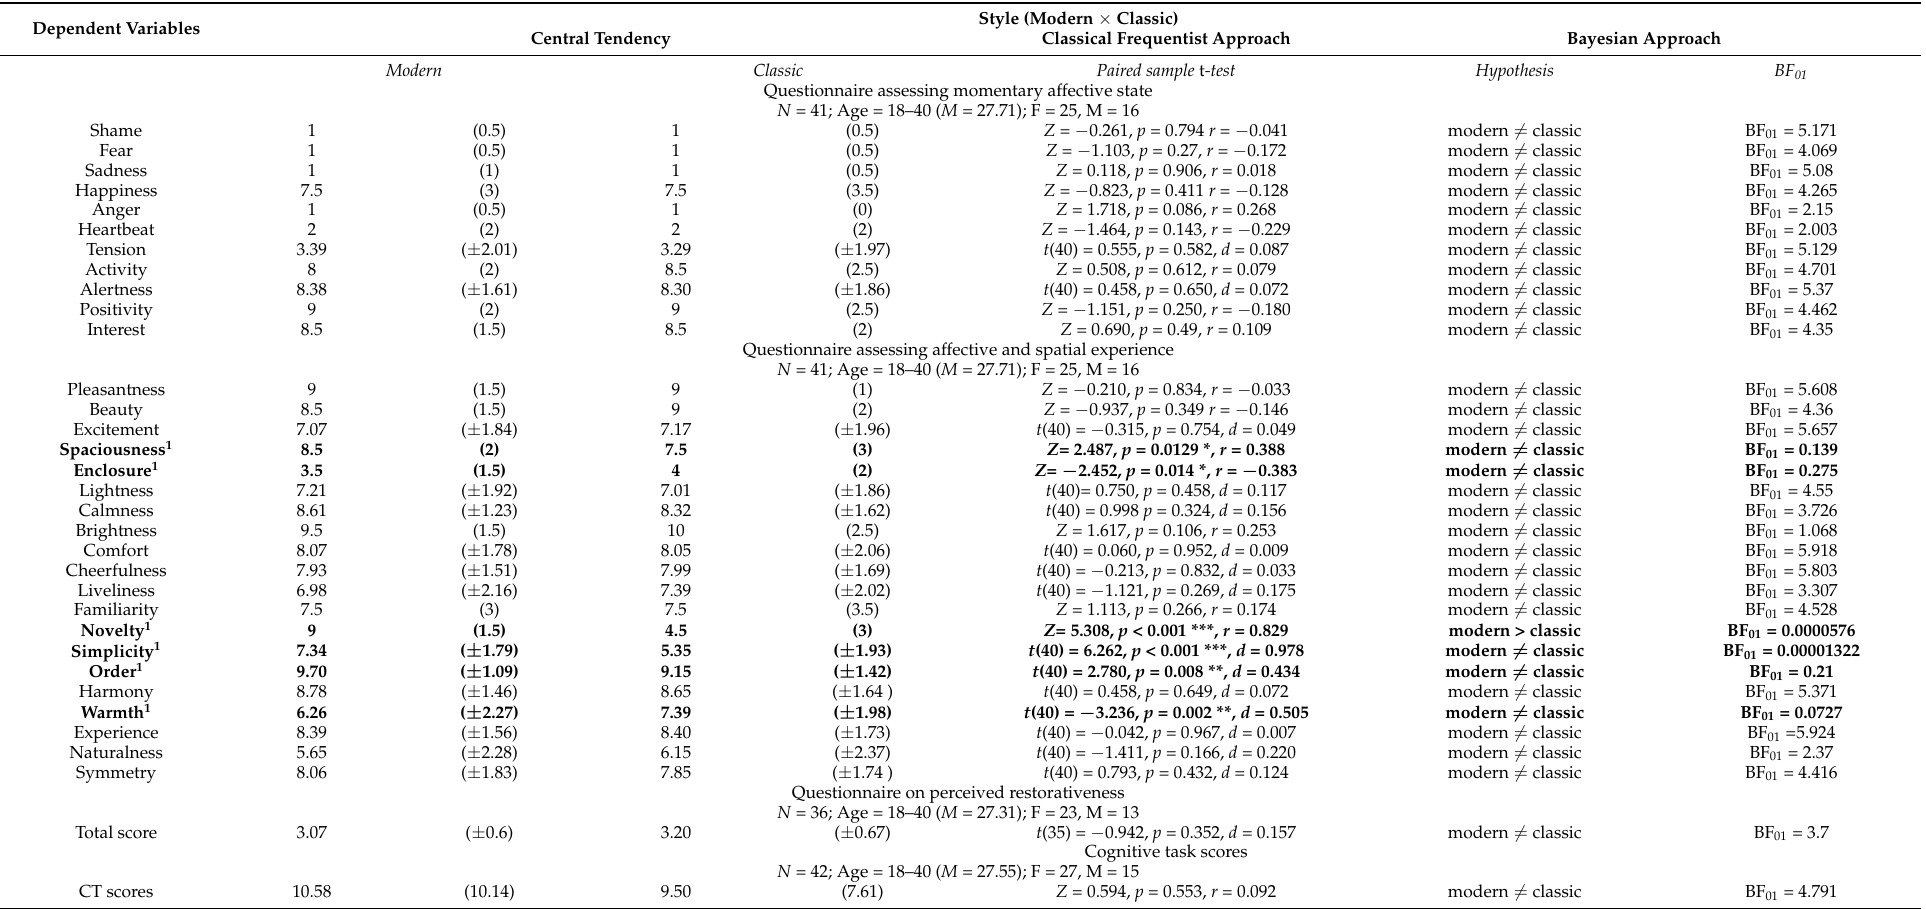
Table 2. Results of the statistical analyses performed on style conditions using a classical frequentist approach and a Bayesian approach, in addition to the central tendency. Where data are normally distributed, means with standard deviation, and Student t -test results are reported. In the case of unmet normality assumption, we report median and IQR, and Wilcoxon signed-rank test results. Effect sizes and alternative hypotheses are also shown for each of the outcome